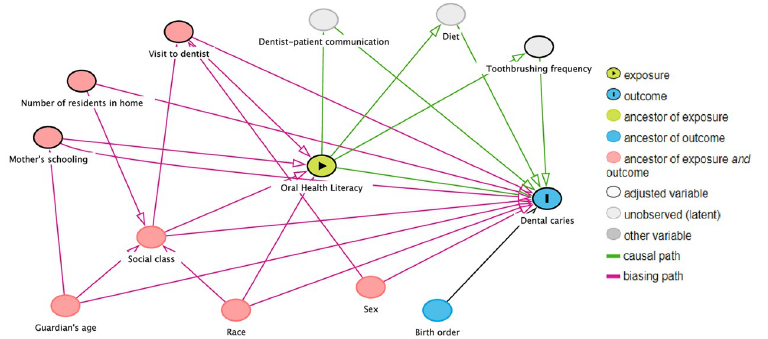
Fig 1. Adopted causal structure of secondary data analysis of dental